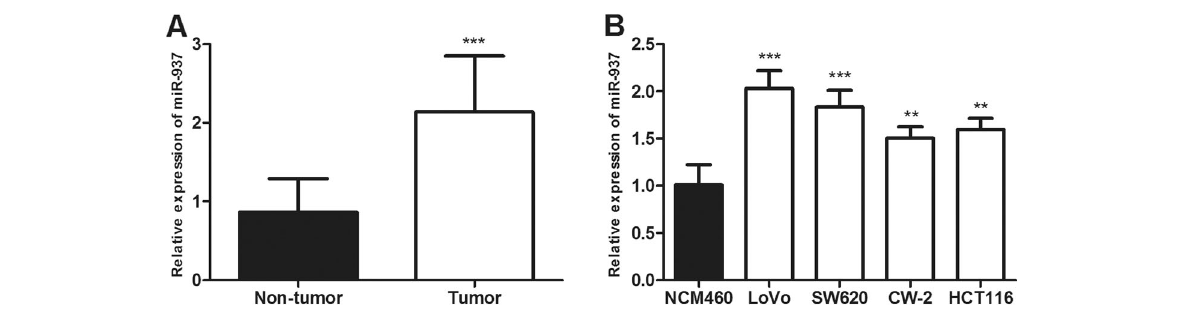
Fig. 1 The miR-937 expression is detected in colon cancer tissues and cell lines via qRT-PCR analysis. a . miR-937 expression is increased in colon cancer tissues compared with adjacent normal tissues. b . miR-937 expression is upregulated in colon cancer cells (LoVo, SW620, CW-2, HCT116)